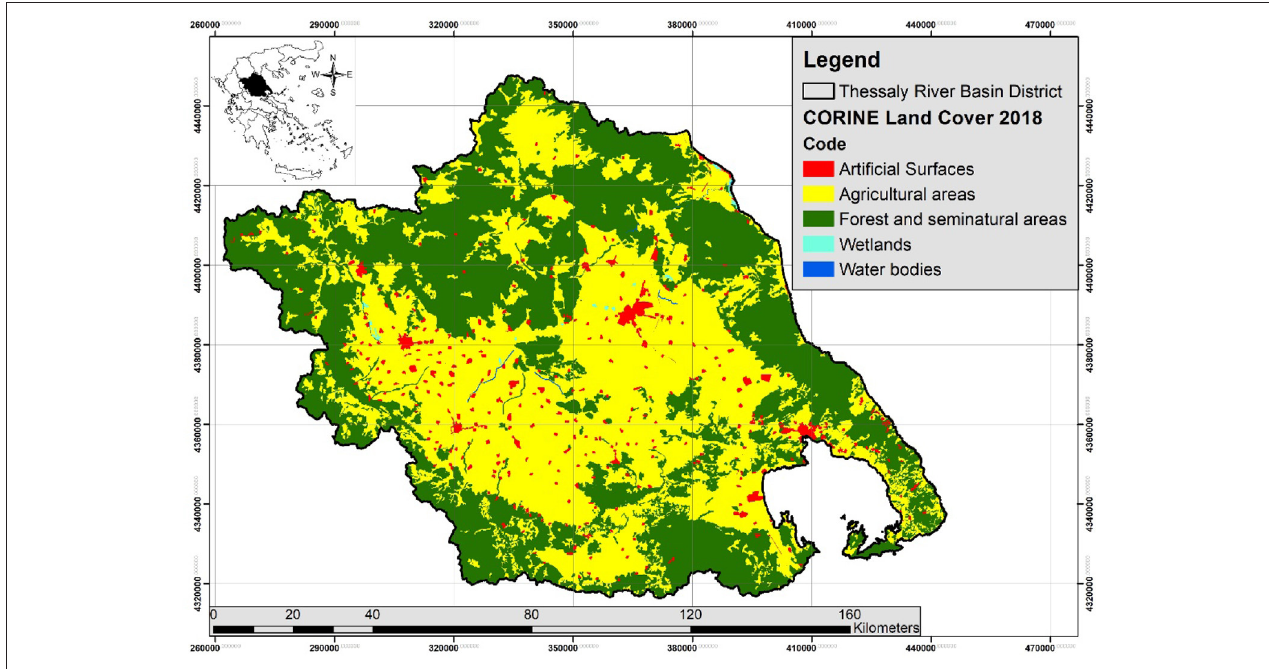
FIGURE 1 | The Basin District of Thessaly, and main land uses.